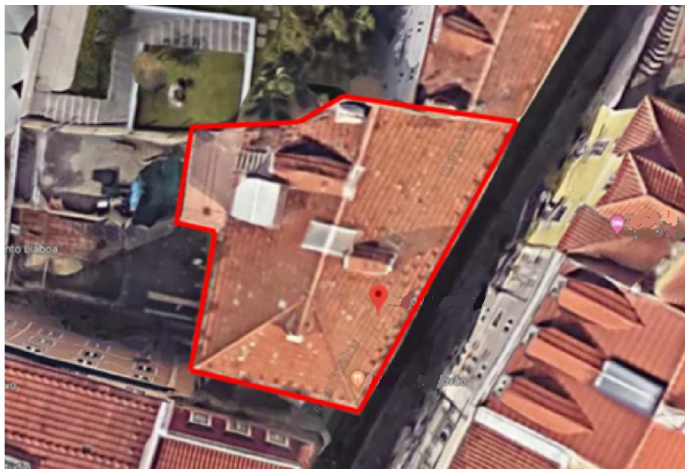
Figure 2. Localization of the case study (from Google Maps).